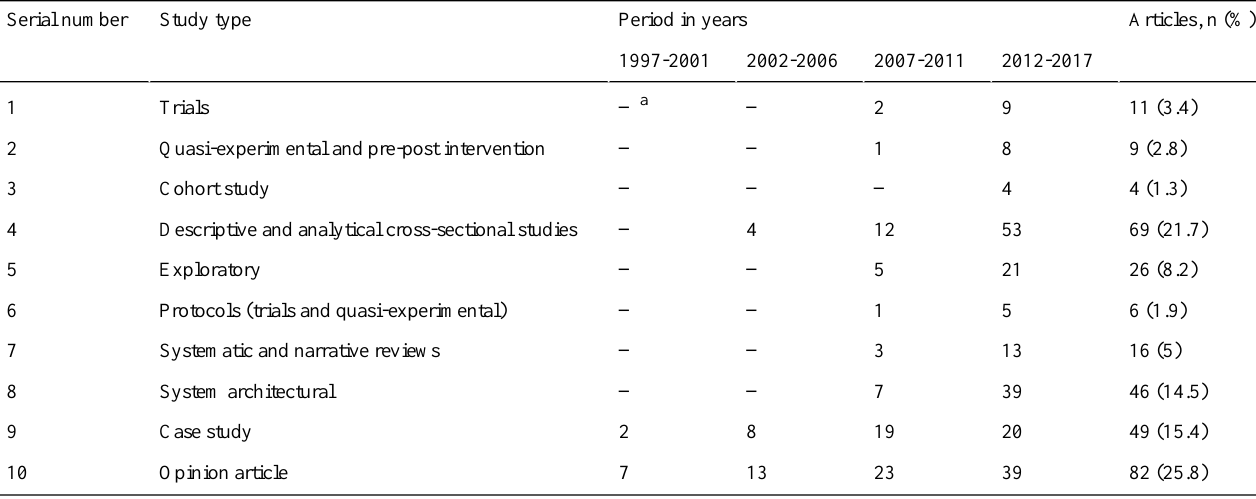
Table 1. Year-wise distribution of the type of published